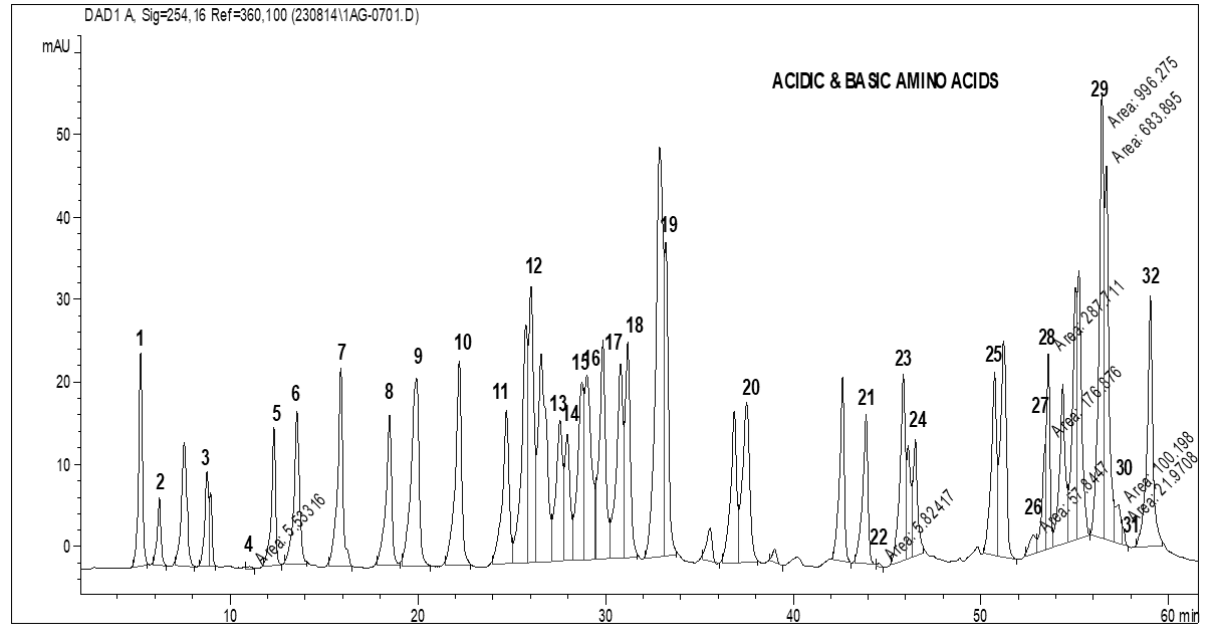
Figure 4. HPLC standard graph showing total amino acids (TAAs) for the estimation of the TAA content present in the isolated strains. Table 1. HPLC standard values of total amino acids (TAAs) for the estimation of the TAA content present in the isolated strains.